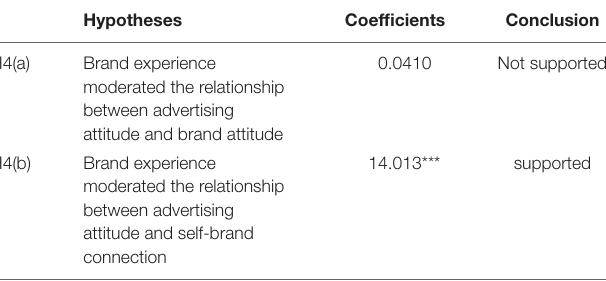
TABLE 7 | Multi-group results according to brand